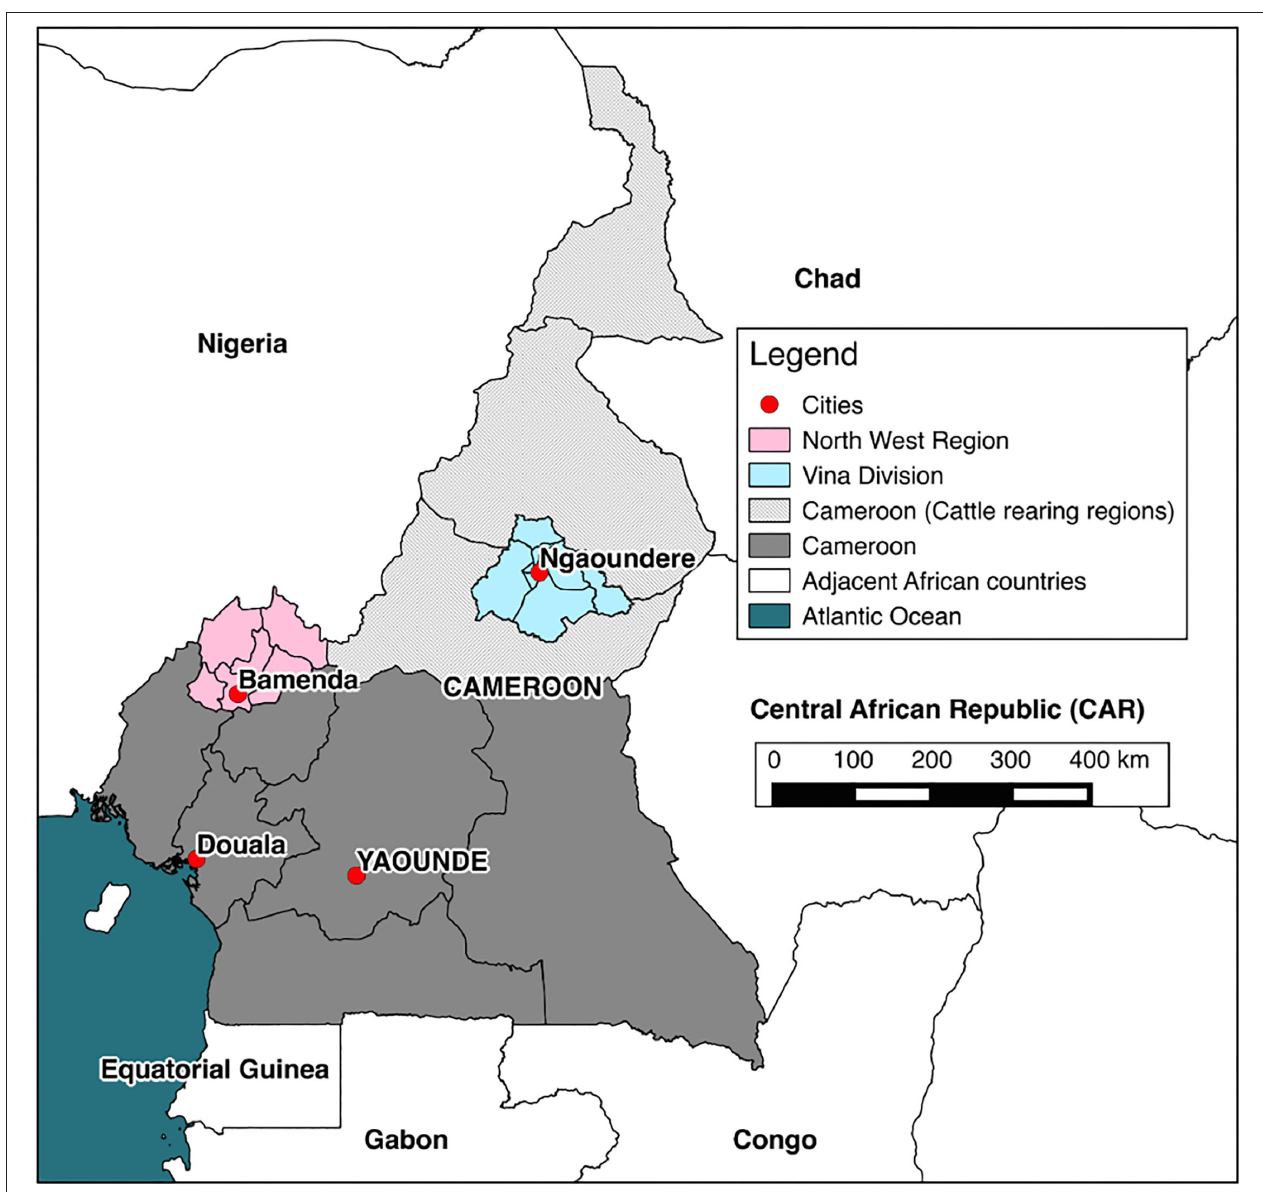
FIGURE 1 | Map of Cameroon. The location of cattle rearing areas (light grey), study sites (pink and blue), and major cities (red).